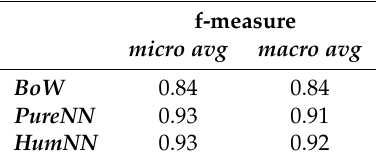
Table 3. Pat-in-the-Loop’s f-measure